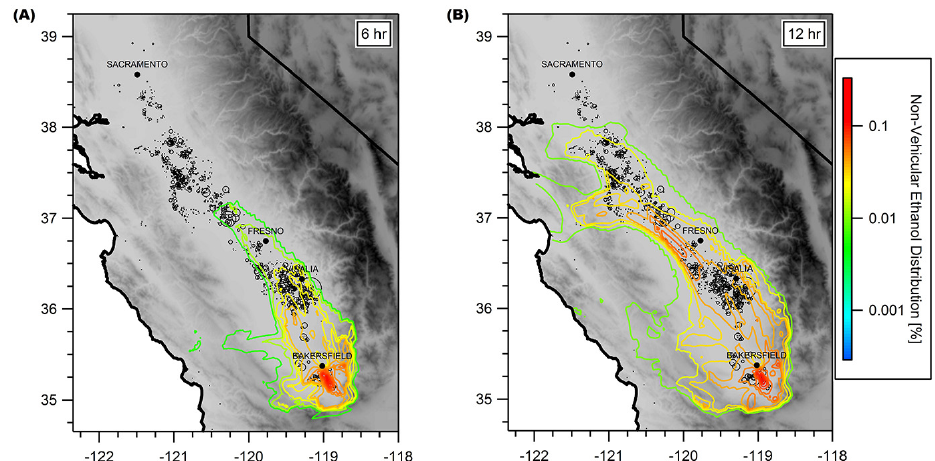
Figure 11. Statistical distribution of emissions of non-vehicular ethanol in the San Joaquin Valley shown as colored contours for 6 and 12h footprints. Modeling results shown with the location of dairies as markers (o) scaled by the size of each dairy.